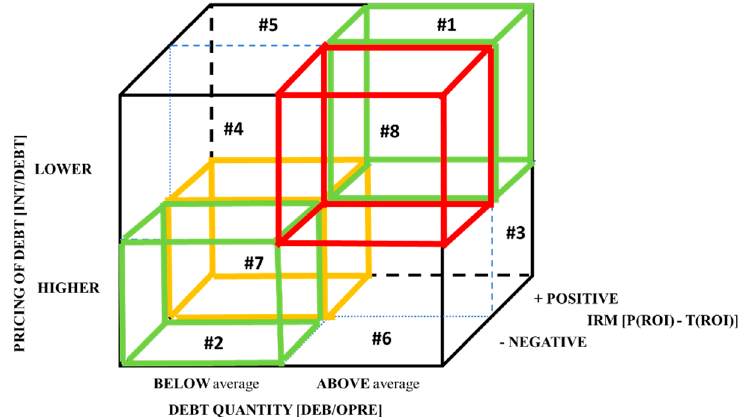
Figure 3. Overall cube-cross-section matches between IRM and bank allowances.